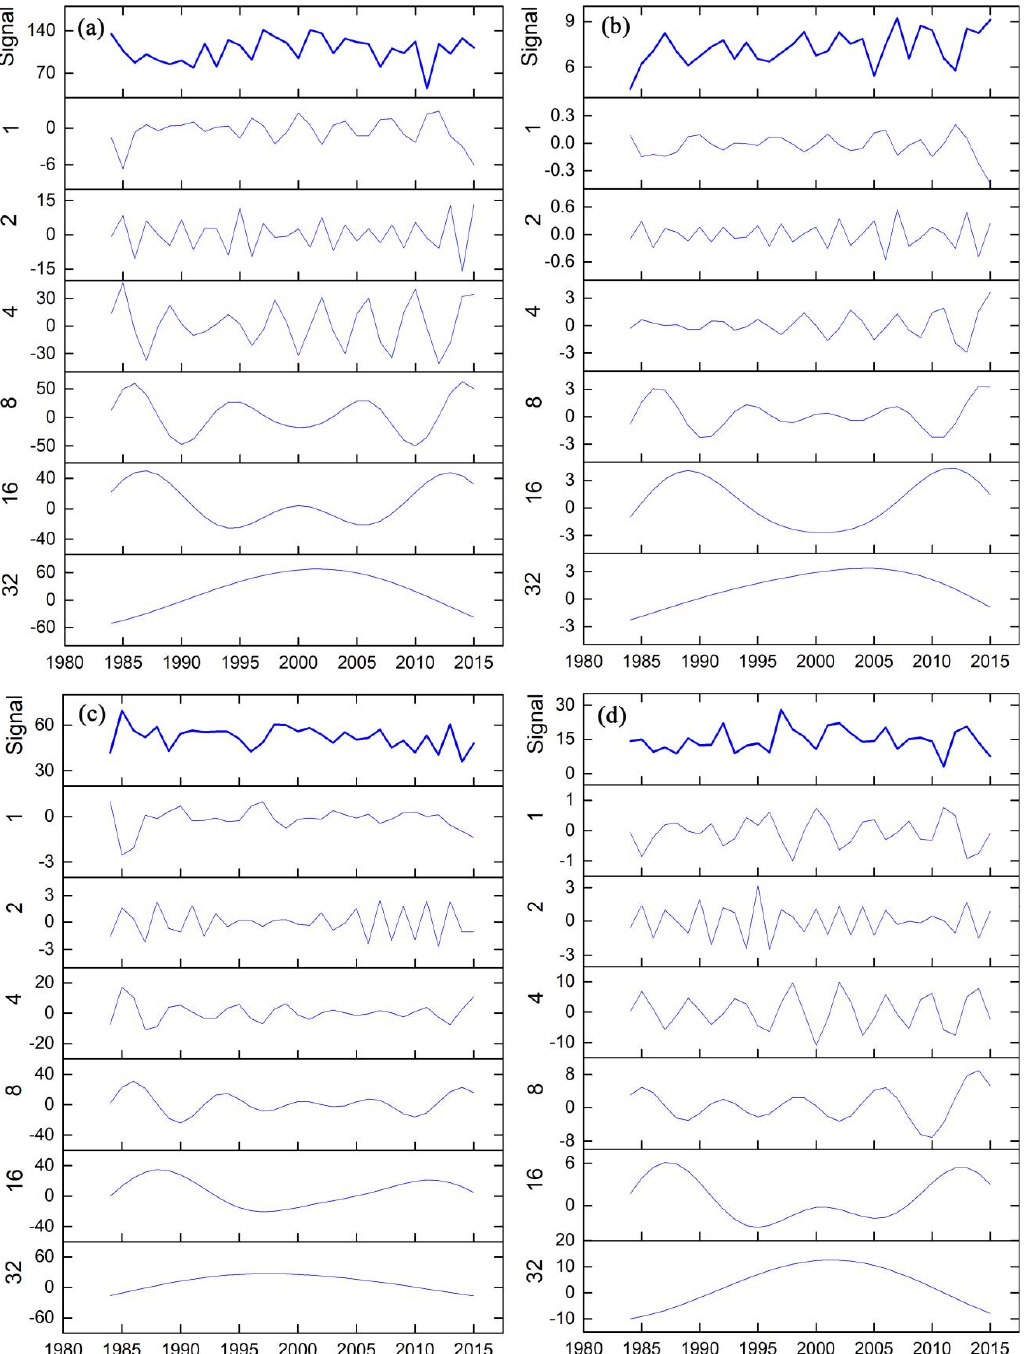
Figure 4. Multi-time-scale variations of rainfall ( a ), temperature ( b ), evaporation ( c ) and runoff ( d ) in